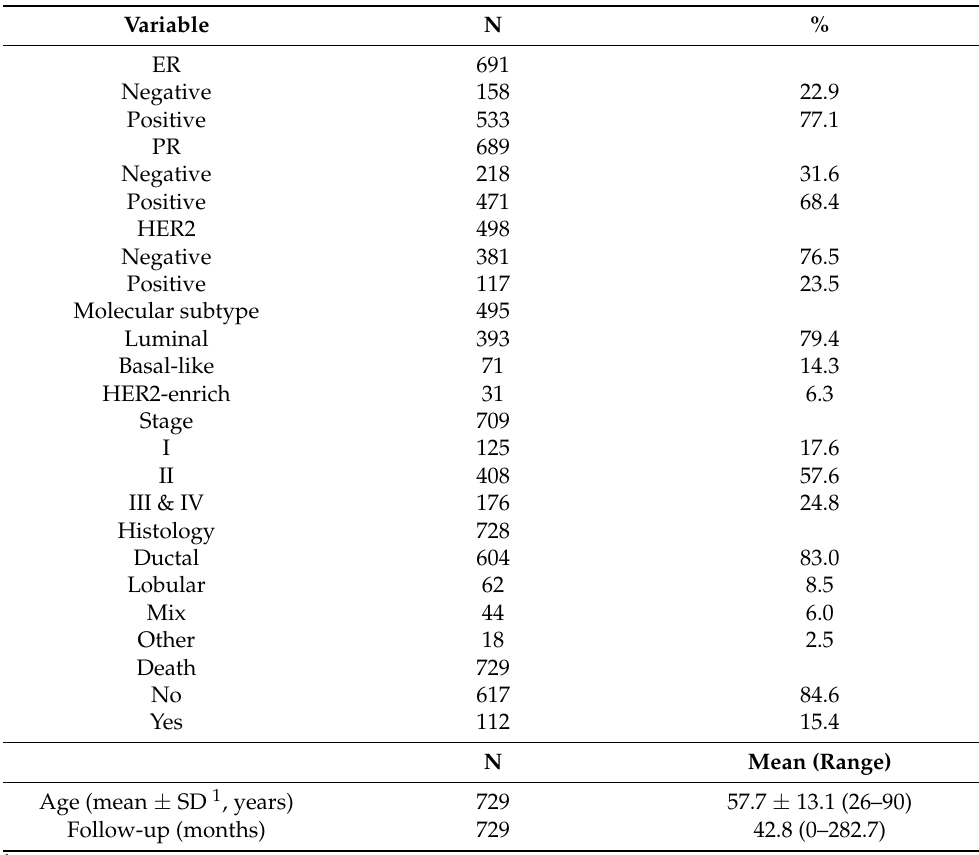
Table 1. Characteristics of 729 breast cancer